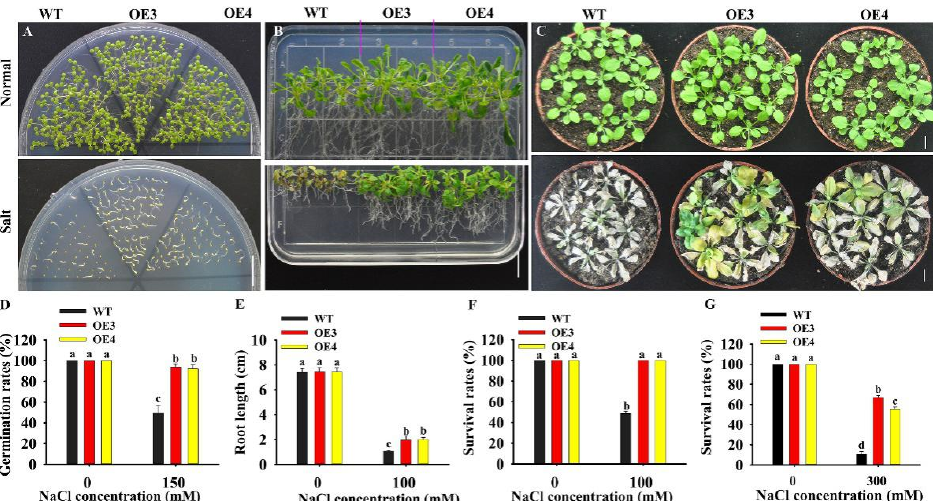
Figure 4. Overexpression of HuERF1 enhances Arabidopsis tolerance to salt stress. ( A,D ) Overexpression of HuERF1 improves the seed germination of Arabidopsis . Seed germination of HuERF1- overexpressing Arabidopsis (OE) on MS medium with 0 or 150 mM NaCl for 6 days ( A ), and germination rates ( D ) were measured. ( B , E , F ) Overexpression of HuERF1 improves the tolerance of Arabidopsis growth to salt stress on MS medium. Arabidopsis seedlings were grown on MS medium with 0 or 100 mM NaCl for 15 days, root length ( E ) and survival rates ( F ) were measured. ( C , G ) Overexpression of HuERF1 improves the tolerance of Arabidopsis growth to salt stress in pots. The seedlings were grown in pots for 3 weeks with 300 mM NaCl, survival rates ( G ) were measured. Different letters ( D – G ) indicate a significant difference at p < 0.05, ANOVA followed by Fisher’s LSD test. Mean values and SDs of three biological replicates are shown. Bars = 1 cm.